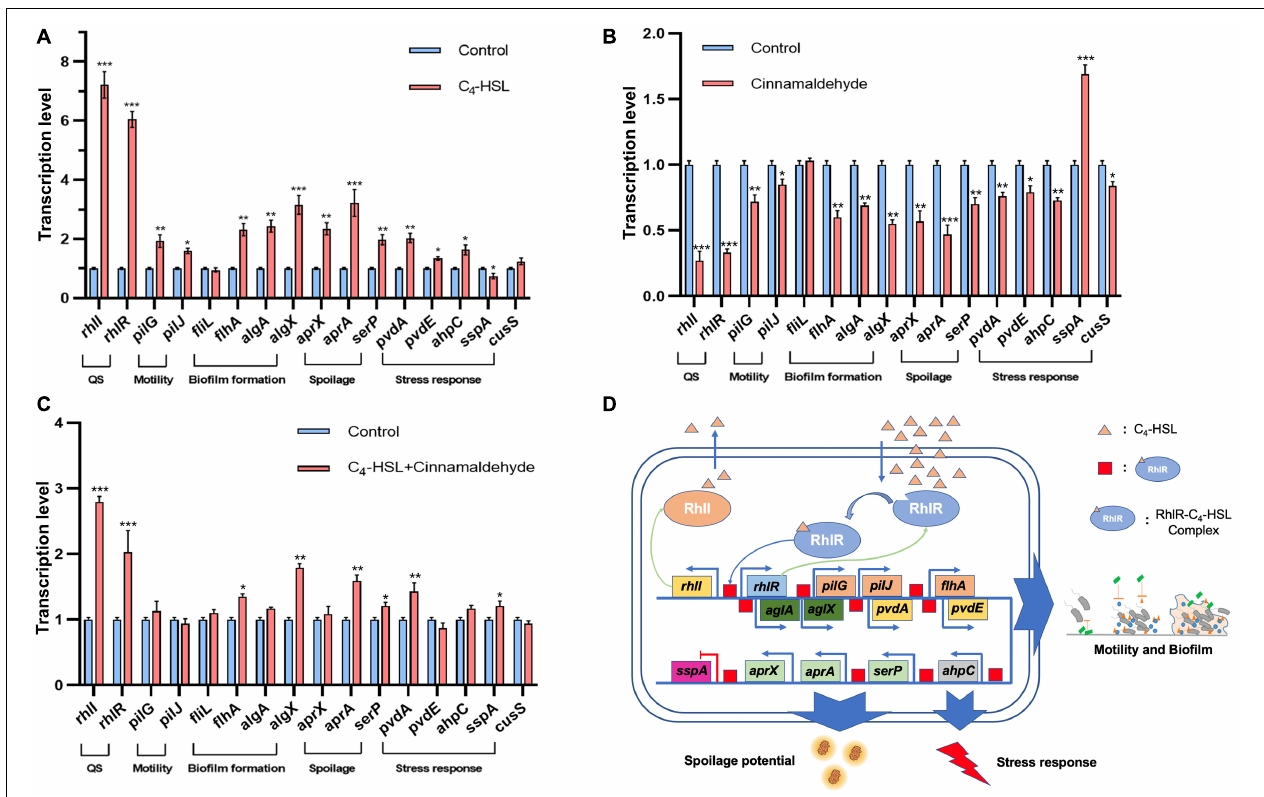
FIGURE 4 | Transcription levels of typical genes related to spoilage and stress response in Pseudomonas fluorescens PF08 after incubation with 20 µ g/mL C 4 -HSL (A) , or 0.1 µ L/mL cinnamaldehyde (B) , or 20 µ g/mL C4-HSL and 0.1 µ L/mL cinnamaldehyde (C) until an optical density at 595 nm (OD 595) of 1 was reached. Schematic diagram of the regulation of QS system in PF08 on the spoilage potential (D) . Data are presented as means ± SD ( n = 3, * P < 0.05, ** P < 0.01, *** P <